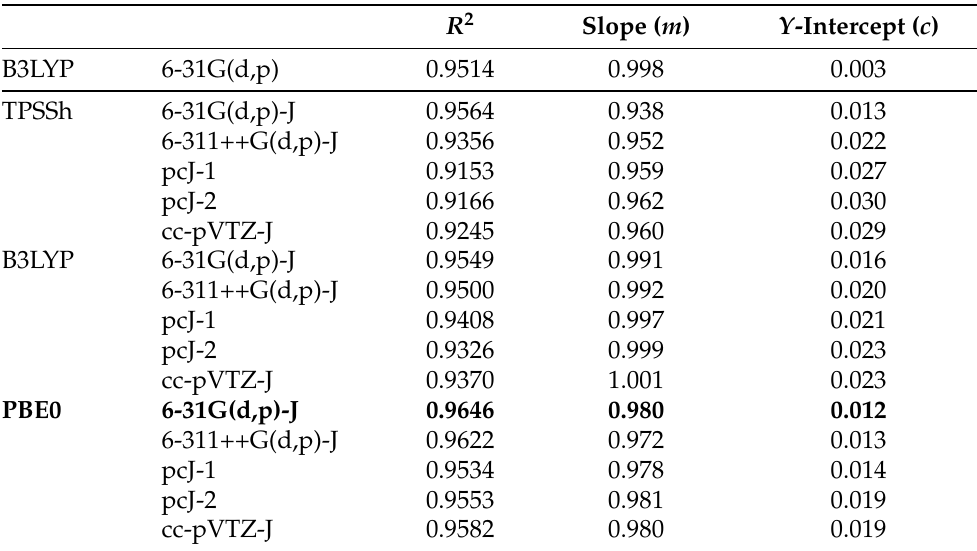
Table 7. DMeAzetA and DMeAzirA couplings absent; R 2 , slope, and intercept values are re-calculated without outliers and shown with reference to B3LYP/6-31G(d,p) values. All results were generated using the PCM solvation